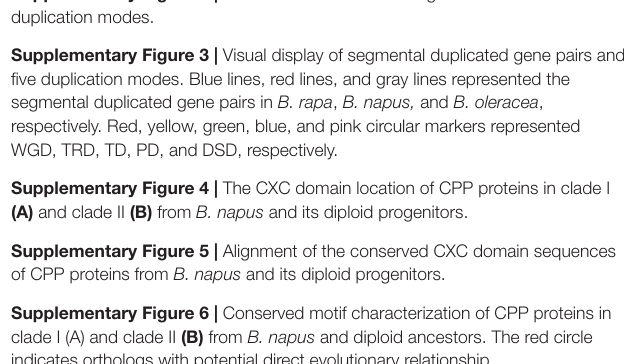
Supplementary Figure 1 | Phenotype figure of B. rapa , B. napus, and B. oleracea under salt stress. Supplementary Figure 2 | Bar chart of the number of genes for five duplication modes. Supplementary Figure 3 | Visual display of segmental duplicated gene pairs and five duplication modes. Blue lines, red lines, and gray lines represented the segmental duplicated gene pairs in B. rapa , B. napus, and B. oleracea , respectively. Red, yellow, green, blue, and pink circular markers represented WGD, TRD, TD, PD, and DSD, respectively. Supplementary Figure 4 | The CXC domain location of CPP proteins in clade I (A) and clade II (B) from B. napus and its diploid progenitors. Supplementary Figure 5 | Alignment of the conserved CXC domain sequences of CPP proteins from B. napus and its diploid progenitors. Supplementary Figure 6 | Conserved motif characterization of CPP proteins in clade I (A) and clade II (B) from B. napus and diploid ancestors. The red circle indicates orthologs with potential direct evolutionary